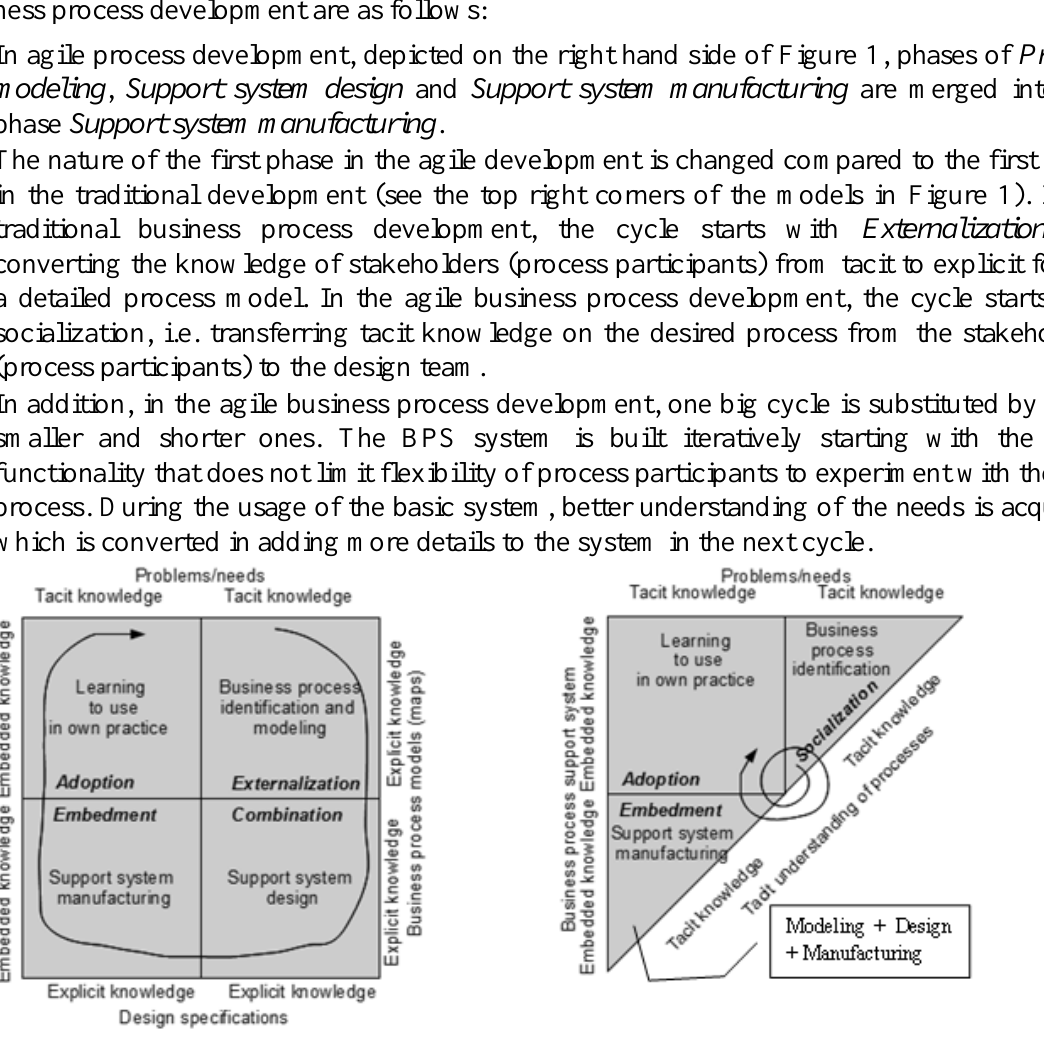
Figure 1. Models of knowledge transformation for the traditional business process development on the left and the agile business process development on the right. Adopted from